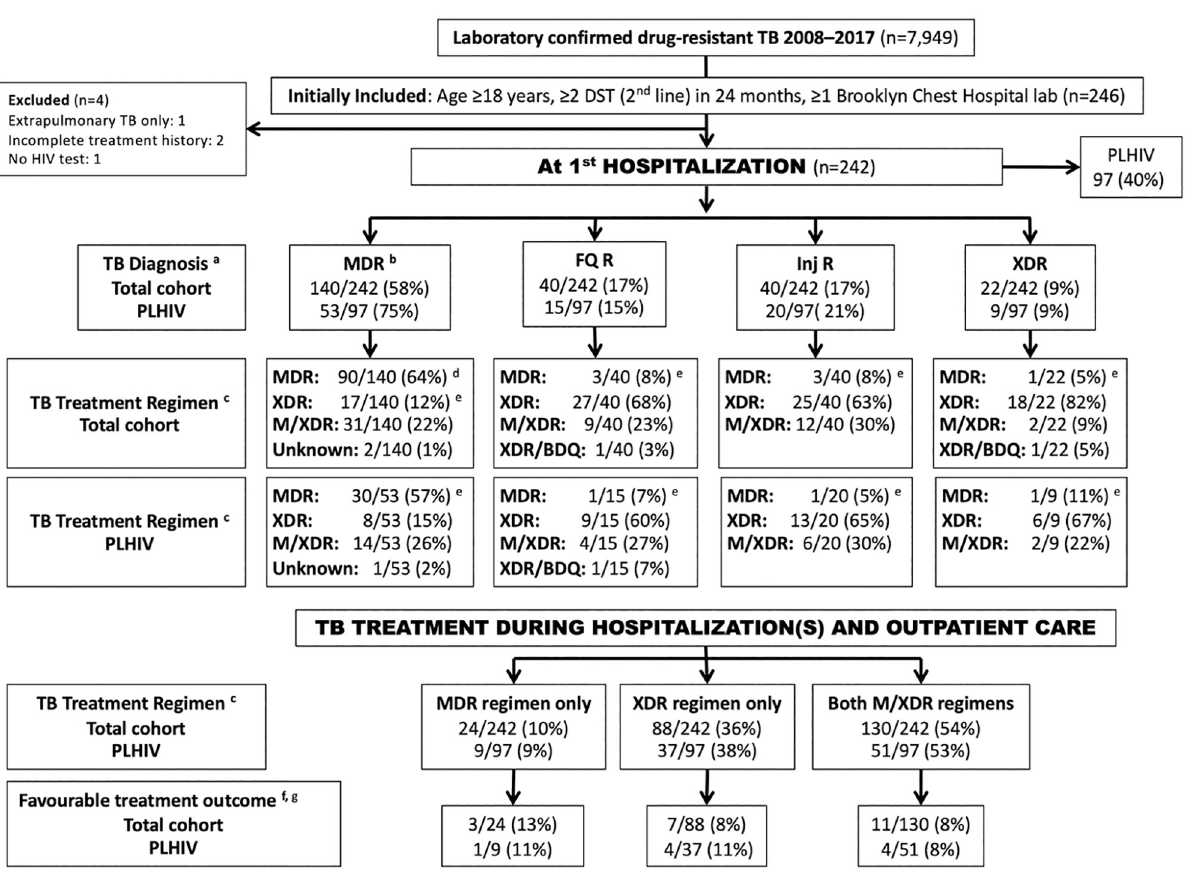
Fig 1. Study profile of patient cohort. Stratified by HIV status, with laboratory confirmed drug-resistant TB, regimens received and treatment outcomes. a TB Diagnosis: MDR: Resistance to isoniazid and rifampicin; FQ R: Resistance to isoniazid and rifampicin and a fluoroquinolone; Inj R: Resistance to isoniazid and rifampicin and a second-line injectable drug (i.e., amikacin, capreomycin or kanamycin); XDR: Resistance to isoniazid and rifampicin, a fluoroquinolone and a second-line injectable drug. b Includes 6 mono-resistant patients [isoniazid resistant, rifampicin susceptible (n = 4); rifampicin resistant, isoniazid susceptible (n = 2)] diagnosed with DR-TB during study period. c MDR regimen included kanamycin; XDR regimen included capreomycin and/or PAS; M/XDR regimen: Treated with a MDR and XDR regimen; XDR/BDQ regimen: Treated with an XDR regimen and bedaquiline added. d Includes 1 patient treated with isoniazid, rifafour (fixed-dose combination of isoniazid, rifampicin, pyrazinamide, and ethambutol), streptomycin. e Diagnosed MDR-TB: XDR regimen prescribed for patients in whom MDR regimen failed; Diagnosed FQ R or Inj R or XDR: MDR regimen prescribed in DR-TB treatment na ï ve patients. f Combination of Cure and Treatment completed. g Outcome of XDR/BDQ treatment regimen not shown. DST: Drug-susceptibility test. PLHIV: People living with HIV.